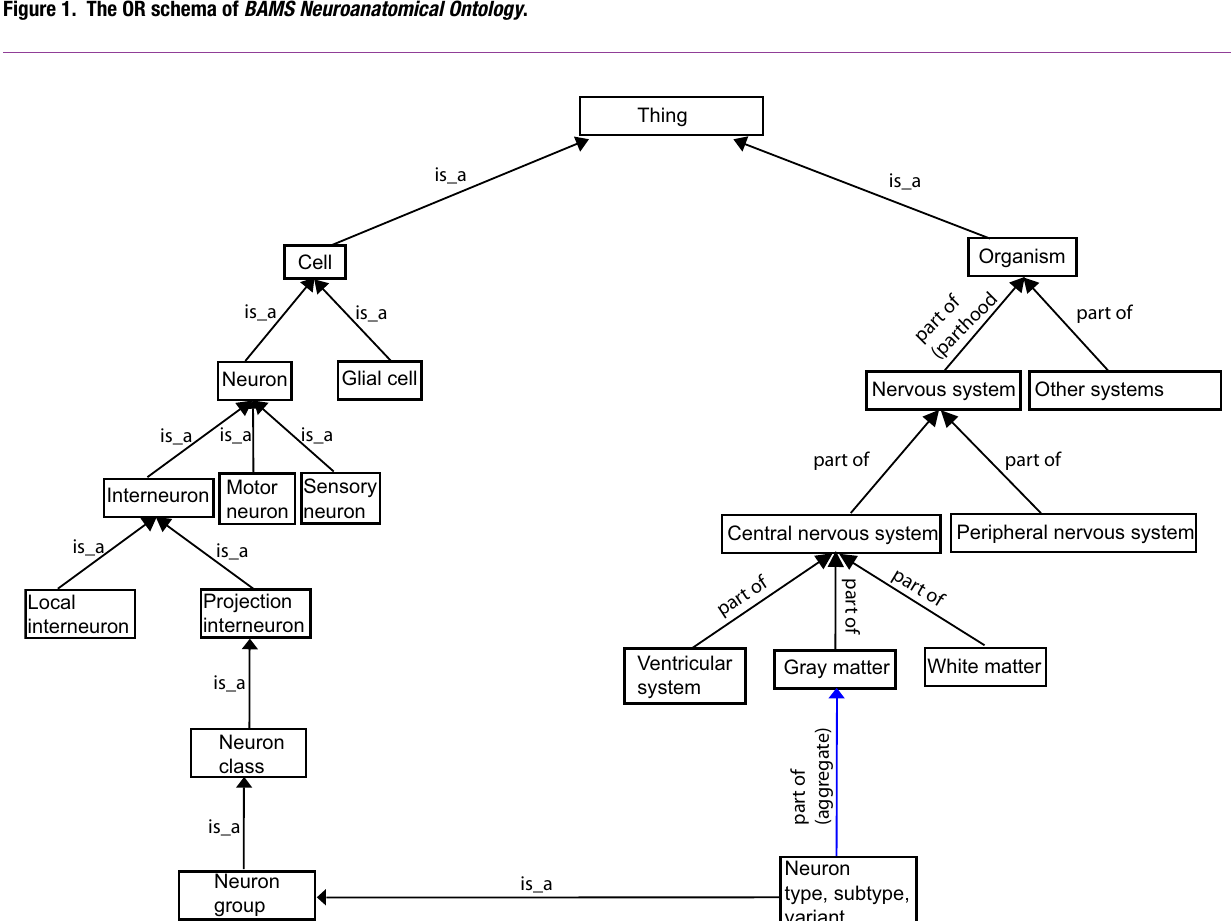
Figure 2. The general structure of BAMS Neuroanatomical Ontology